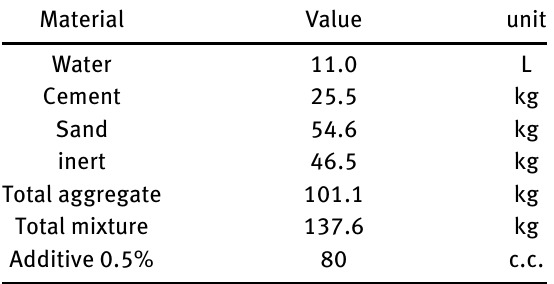
Table 1: Mix design of the concrete